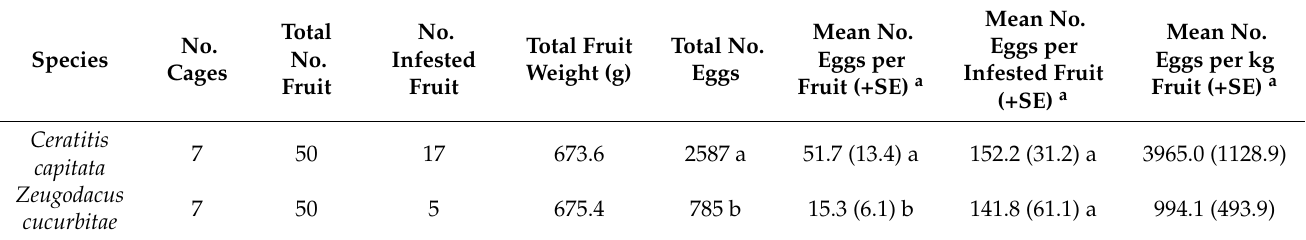
Table 2. Oviposition rate in finger lime fruit by Ceratitis capitata and Zeugodacus cucurbitae in no-choice cage exposures with 50 gravid flies for 24